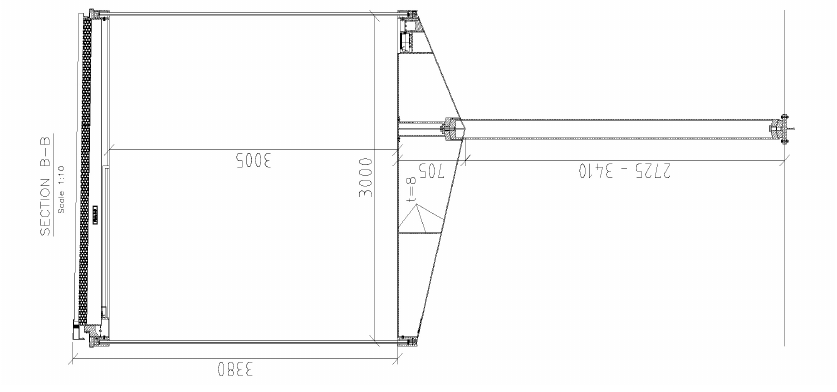
Figure 9: Section through the walkway with